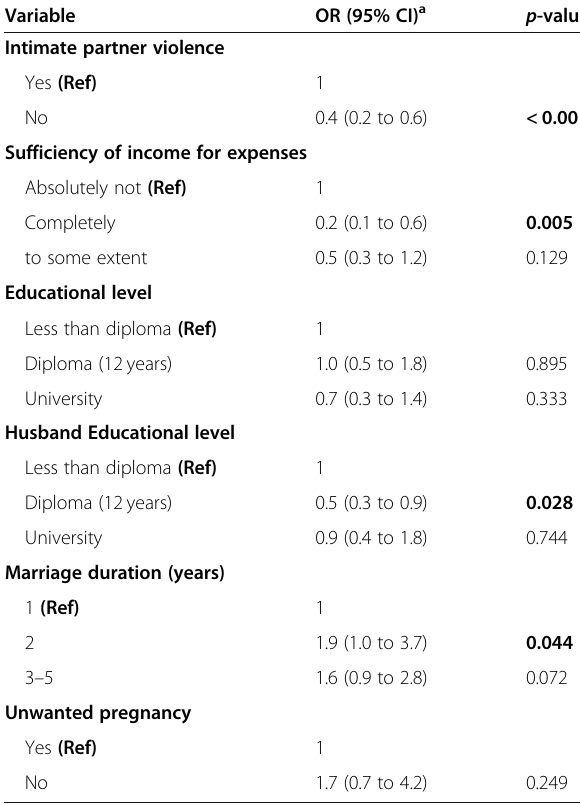
Table 4 Correlation between sexual dysfunction and socio- demographic characteristic and intimate partner violence ( n =